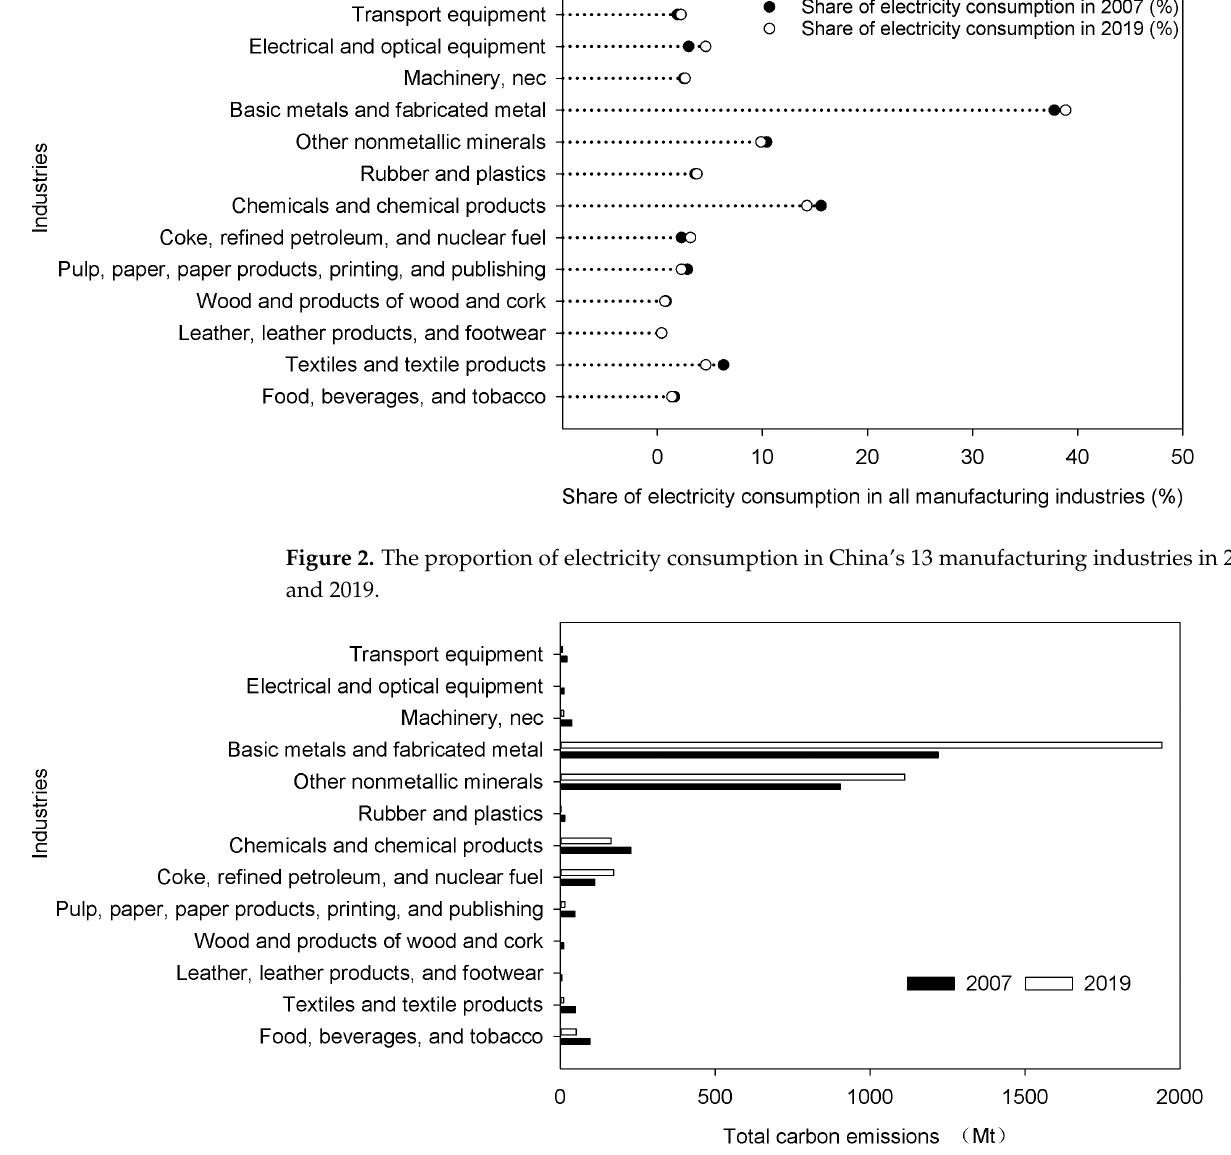
Figure 3. Total carbon emissions of China’s 13 manufacturing industries in 2007 and 2019.